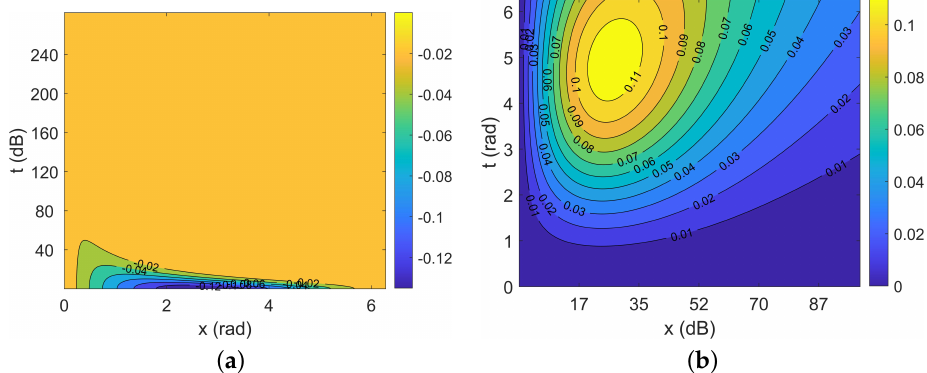
Figure 6. The contour of the partial derivative of the RVoG function. k e ranges between 0 and 1 dB/m [14], and k z > 0.01 m − 1 , θ = π /4. ( a ) Direction of h v . ( b ) Direction of p 1